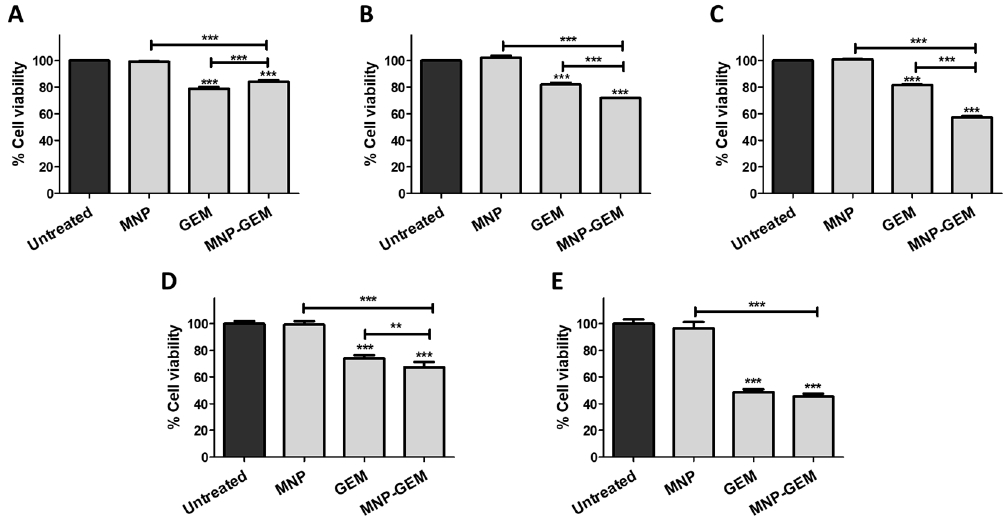
Figure 2. Cell viability assays 72 h after treatment in: ( A – C ) PANC-1; ( D ) BxPC-3; ( E ) MIA Paca-2. Conditions tested ( A ) , ( D , E ) MNP 0.1 mg Fe/mL, GEM 4.5 μ M, MNP-GEM 0.1 mg Fe/mL 4.5 μ M. ( B ): MNP 0.5 mg Fe/mL, GEM 22.5 μ M, MNP-GEM 0.5 mg Fe/mL 22.5 μ M. ( C ): MNP 2 mg Fe/mL, GEM 90 μ M, MNP-GEM 2 mg Fe/mL 90 μ M. Data represent means ± SD. Statistical analysis was performed using a one-way ANOVA test (each group vs. control). ** p < 0.01, *** p < 0.001.